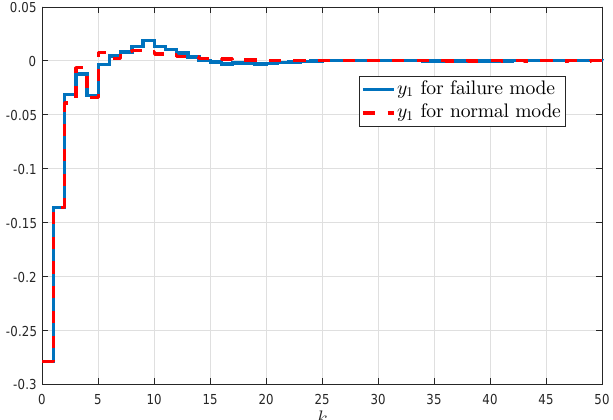
Figure 2. The response of system output variable y 1 .